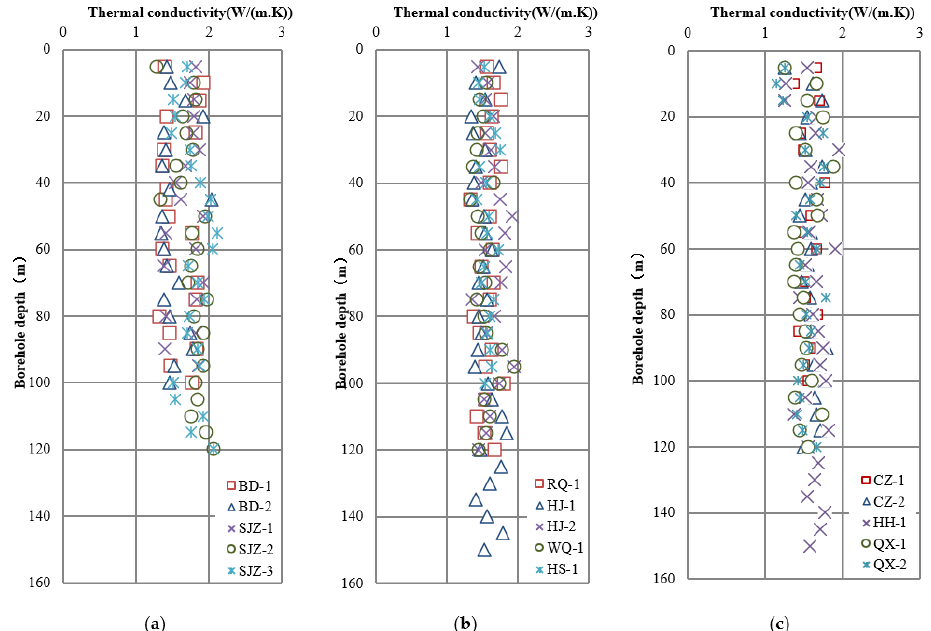
Figure 4. Vertical distribution of the thermal conductivity of locations in different regions: ( a ) the piedmont plain; ( b ) the central plain; and ( c ) the coastal plain.